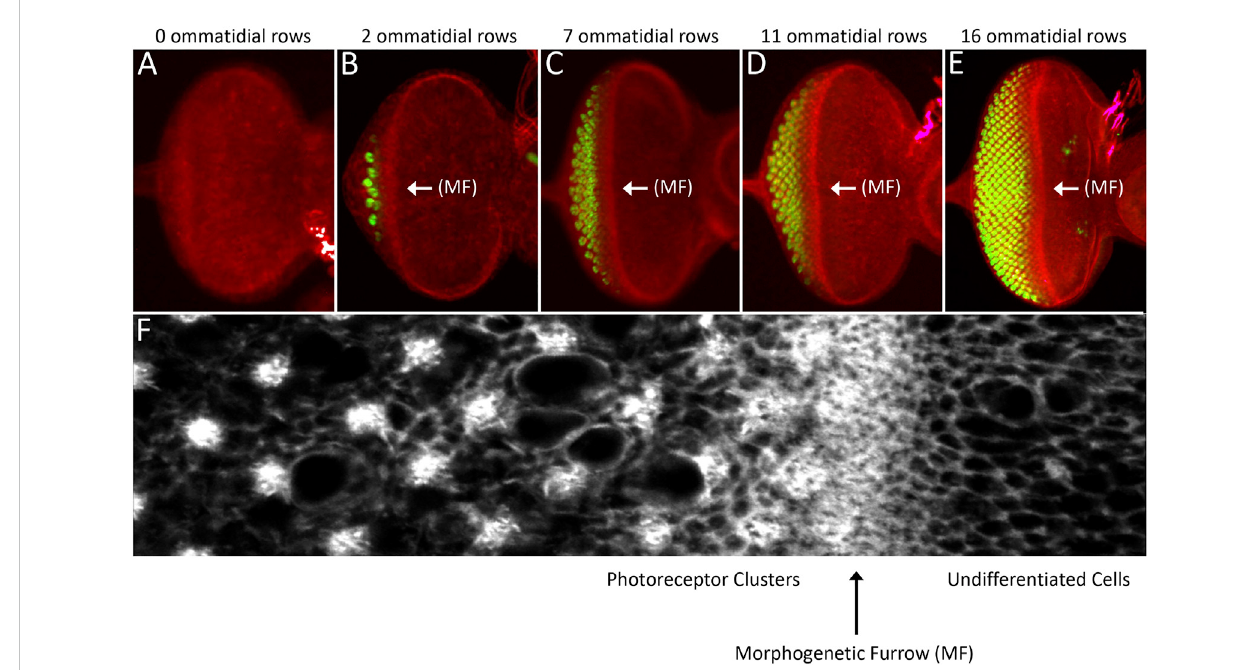
FIGURE 9 Themorphogeneticfurrowpatternstheeye fi eldduringthethirdlarvalinstar. (A – E) Lightmicroscopeimagesofdifferentstagethirdlarvalinstareye discs showing the progression of the morphogenetic furrow. As the furrow passes across the epithelium, columns of photoreceptor clusters (ELAV, green) are producedinits wake. (C) Highmagni fi cation view ofthe areasurrounding themorphogeneticfurrow.Cells ahead thefurrow have large apical pro fi lesandaredividingrandomly.Asthefurrowapproaches,cellsconstricttheirapicalpro fi lesandenterG1arrest.Ascellsexitthefurrowgroupsof periodically spaced cells exist the cell cycle and form the fi rst fi ve photoreceptors of each unit eyes. Cells between these developing ommatidia will eventually undergo one fi nal round of mitosis and give rise to the fi nal three photoreceptor neuron and twelve non-neuronal accessory cells. (F) A high magni fi cation image showing a region around the morphogenetic